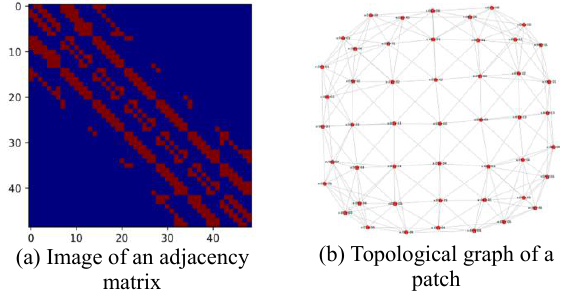
Figure 3 . Visualization of localized adjacency matrix (without adding additional noises) in two different